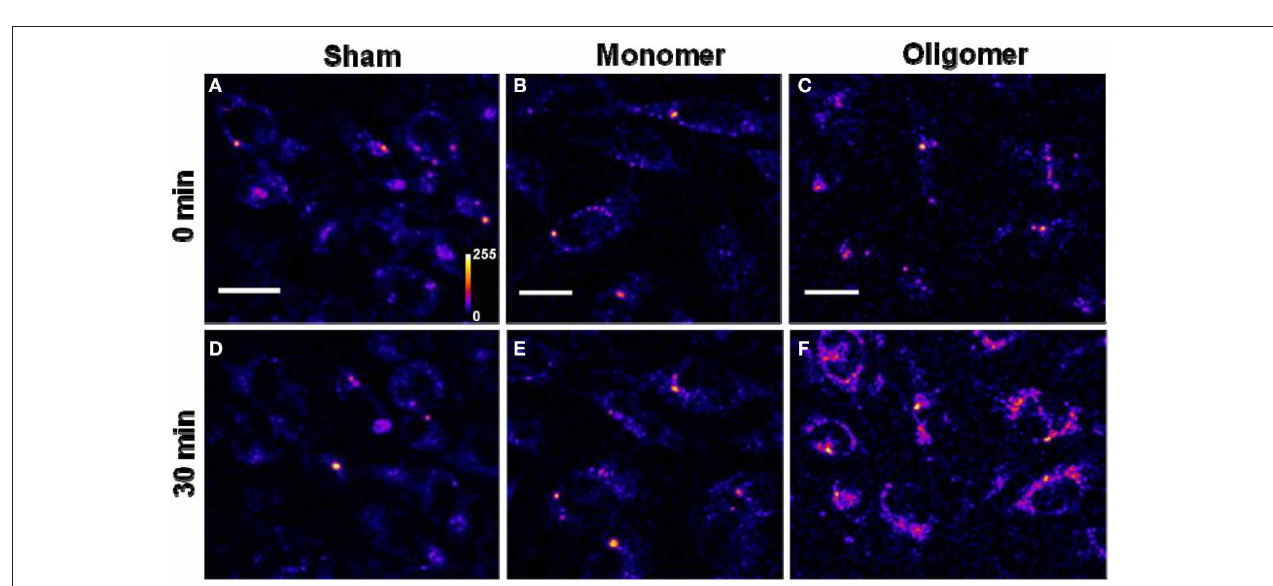
FIGURE 3 | Binding of A β 40 monomers and oligomers to RN46A cell membranes. (A–C) Confocal sections of three sets of cells (excitation 543nm, emission 550–700nm). (D–F) Corresponding sets of cells after